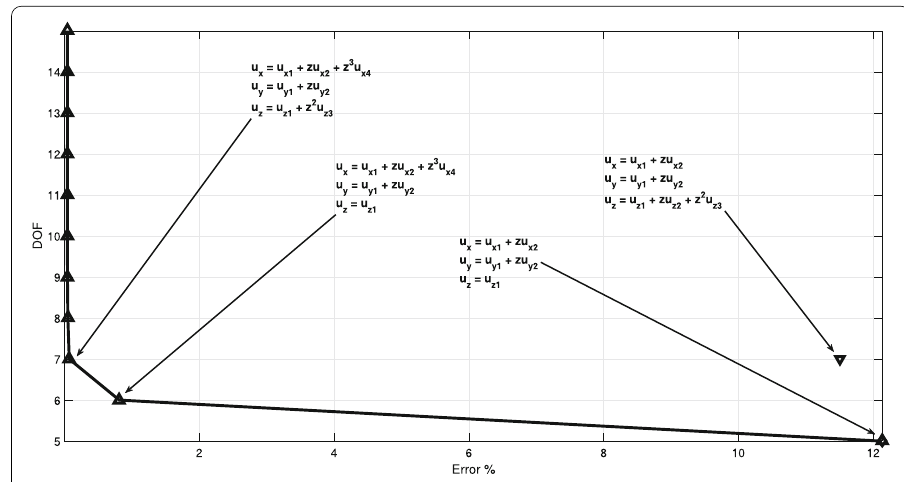
Fig. 10 BTD for 0/90/0, a/h = 10 with seven, six and five DOF models indicated